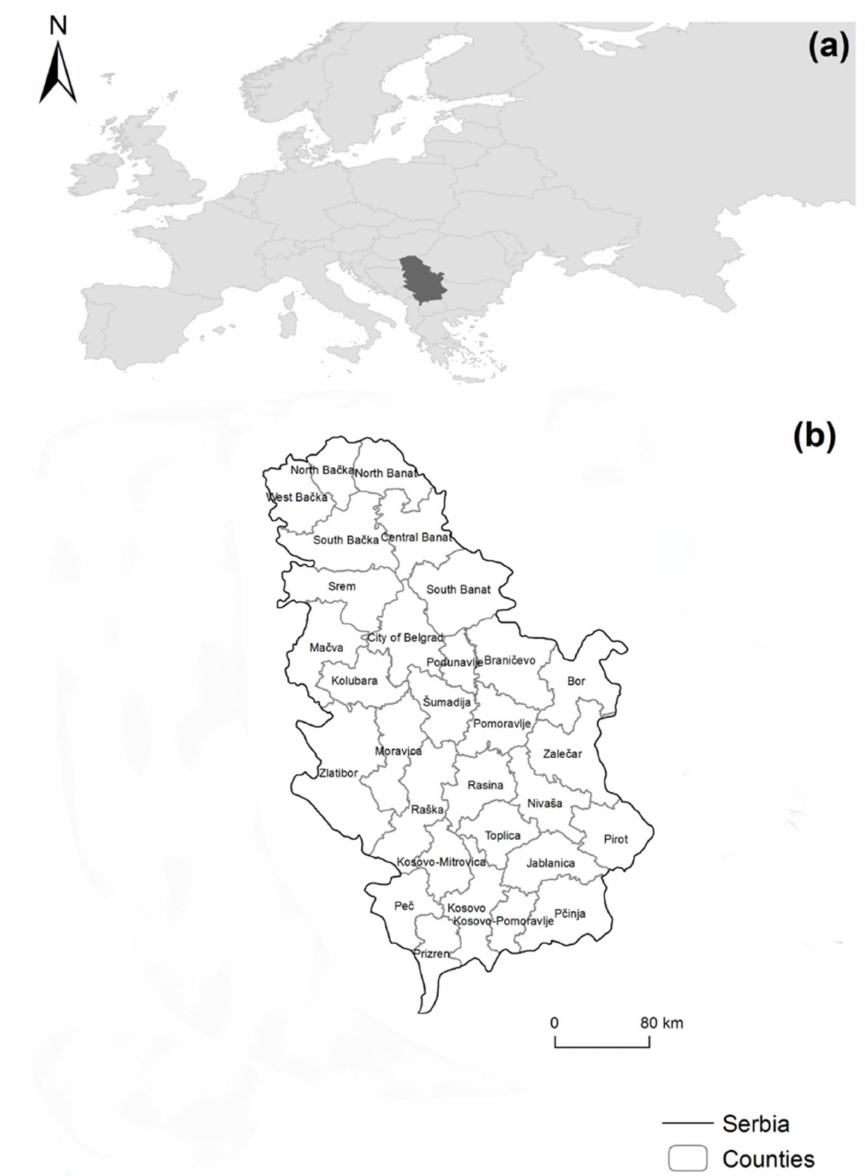
Figure 2. Study area. Location of Serbia ( a ); counties of Serbia ( b